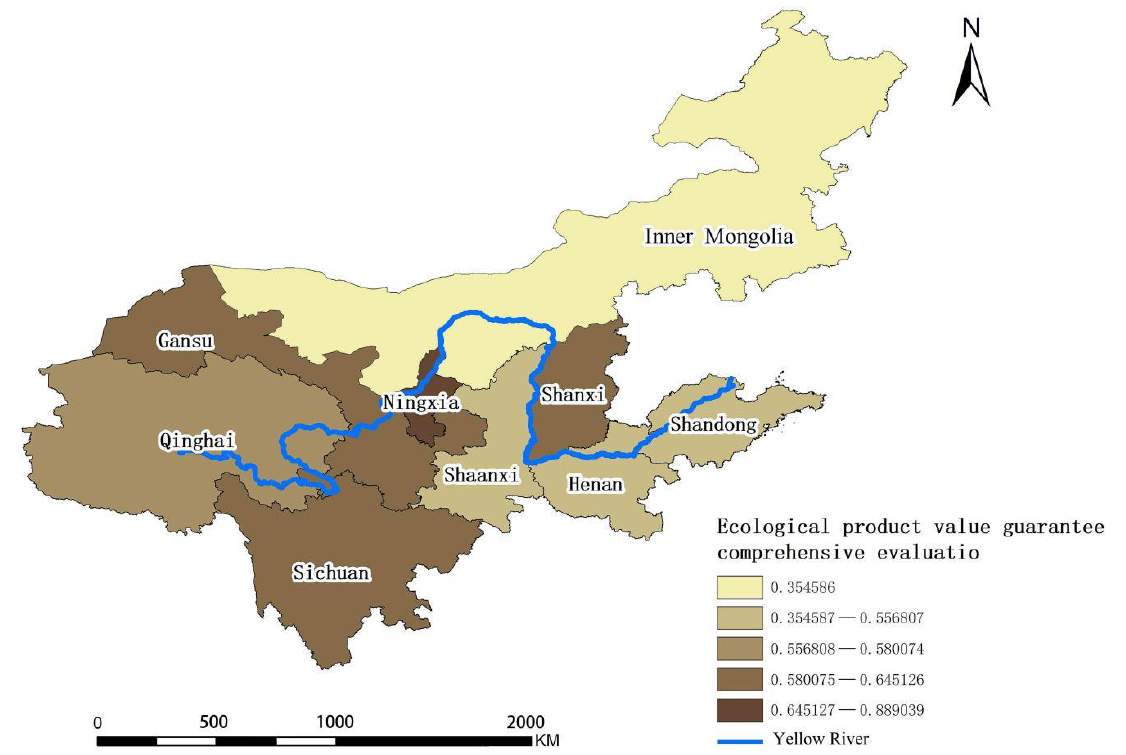
Figure 7. The guarantee mechanism for the realization of the EPV